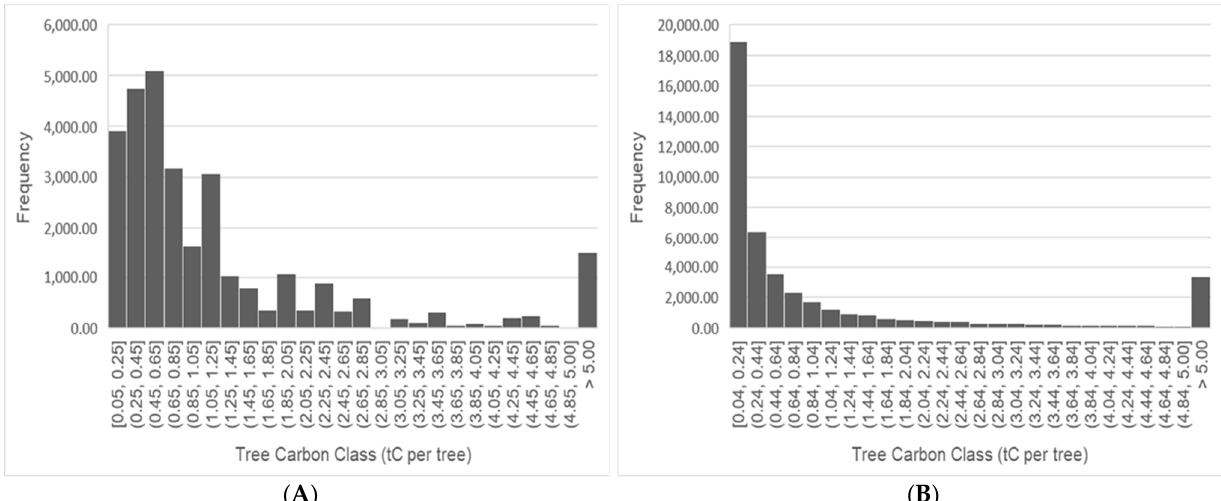
Figure 9. The distribution of tree carbon (Mg), where ( A ) is from this study and ( B ) is from the data presented in Brandt et al. The majority of trees were in the low carbon stock classes in the Brandt et al. dataset while medium size trees were the most frequent in this study.